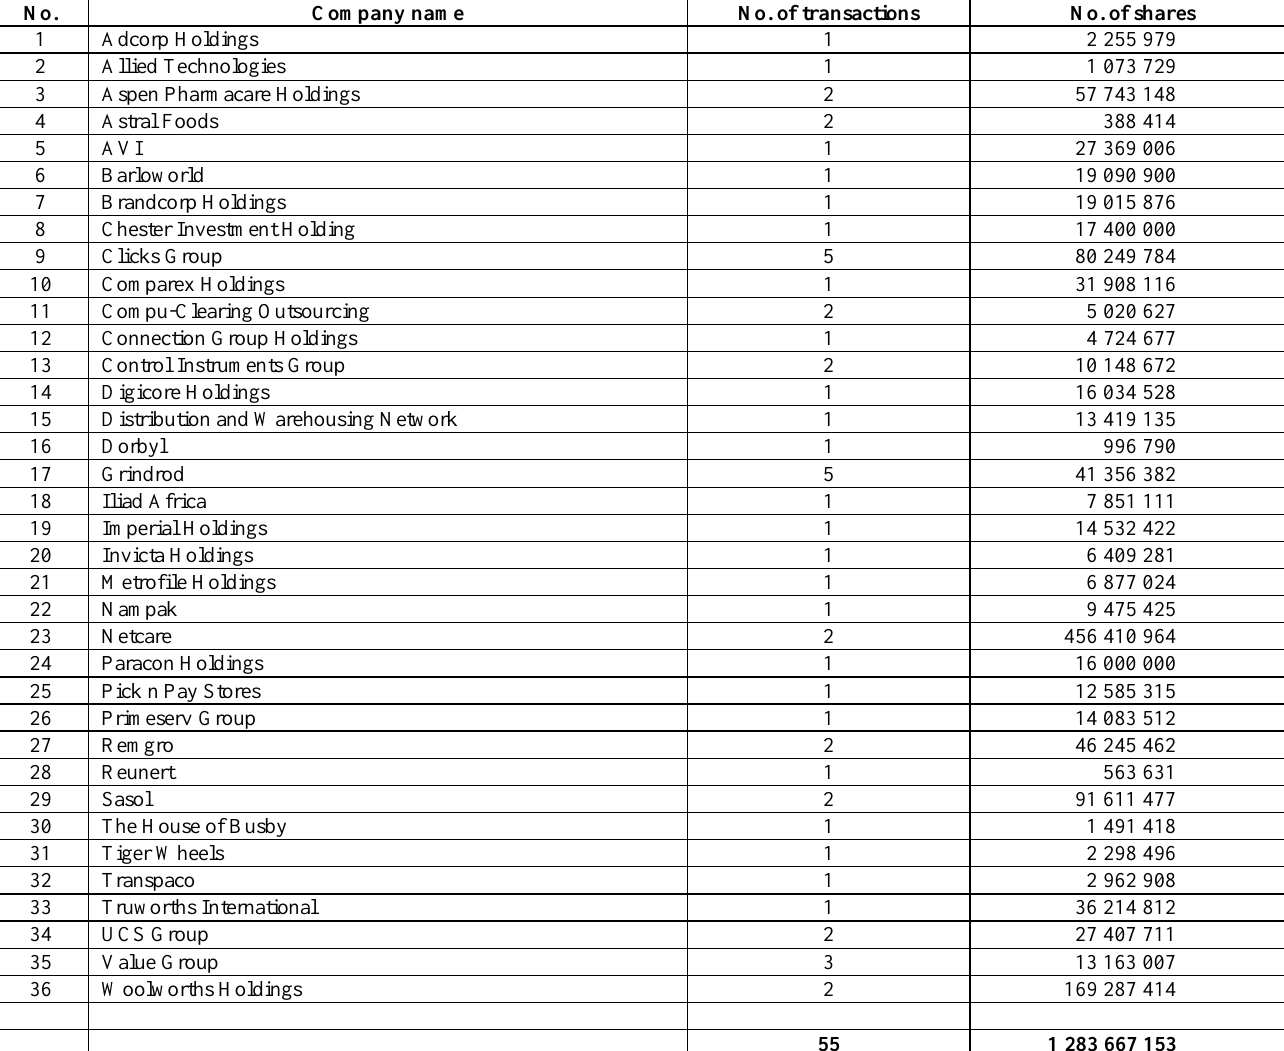
Table 1: Companies repurchasing treasury shares from